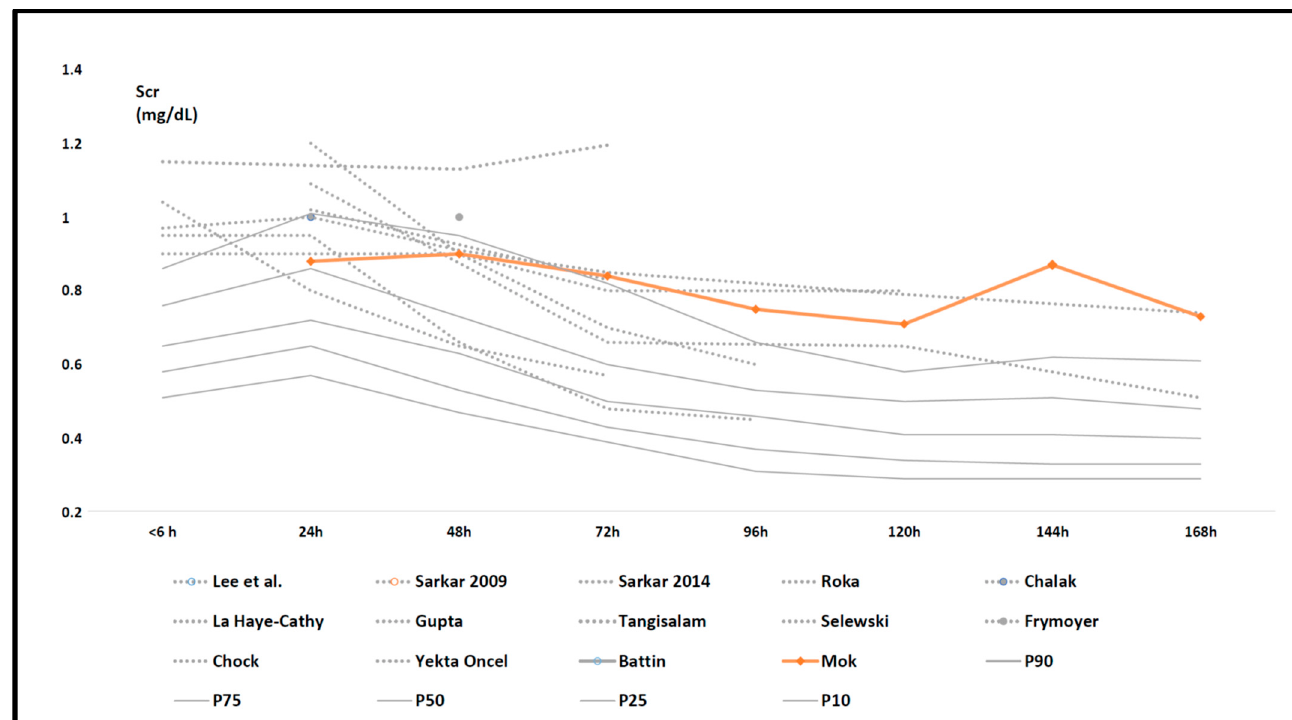
Figure 4. Serum creatinine (Scr) data as reported in the individual retained studies (dashed, grey trends) compared to centile (10th, 25th, 50th, 75th, and 90th centiles) trend values (full grey) in the reference cohort (Table 1) in the first week of postnatal life with the trends in Scr mean values as reported in the Mok cohort (66 cases, orange) added [27,36–48,55].